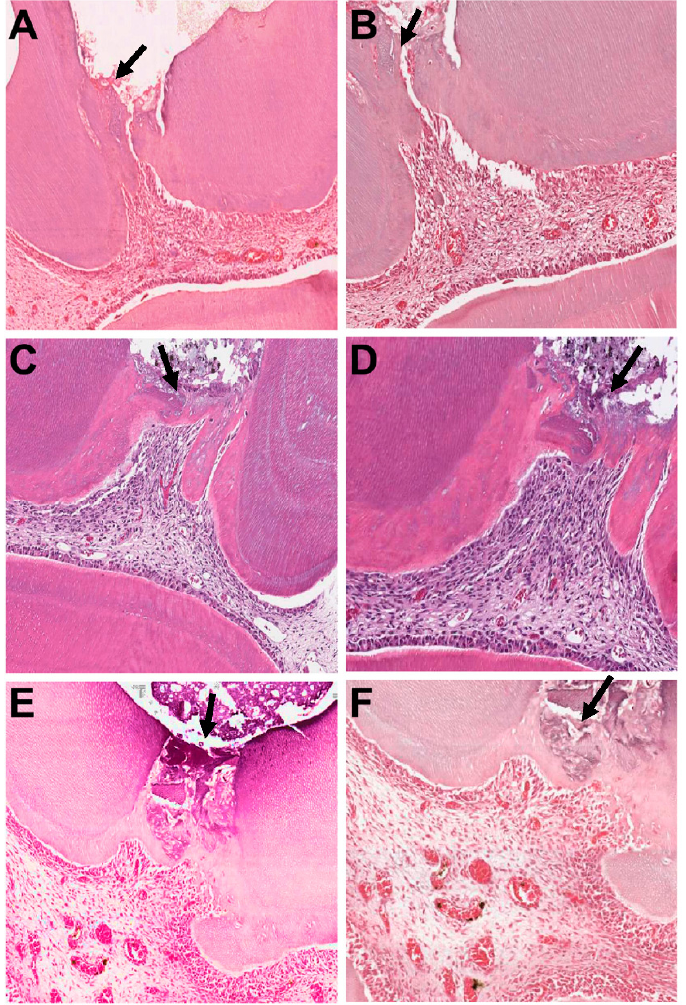
Figure 2. Histologic features of maxillary first molars capped with ( A , B ) iloprost, ( C , D ) MTA, and ( E , F ) MTA-iloprost at one week. Higher magnification showing dilated and engorged blood vessels in ( B ) iloprost and ( F ) MTA-iloprost specimens. H&E stain ×200 and ×400 magnification. Arrows indicate tertiary dentin.